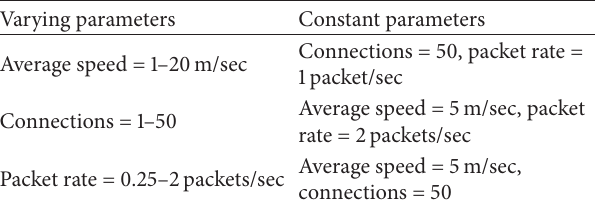
Table 3: Scenario